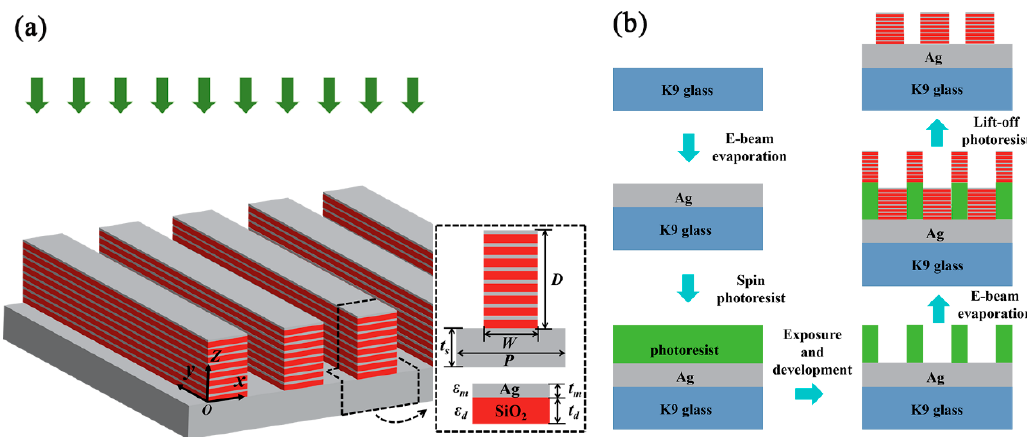
Figure 1. ( a ) Schematic diagram of the HRA illuminated by normal incident TM wave (magnetic field t d = 35 nm, f = 0.22, and t s = 100 nm. ( b ) Fabrication process flow of the